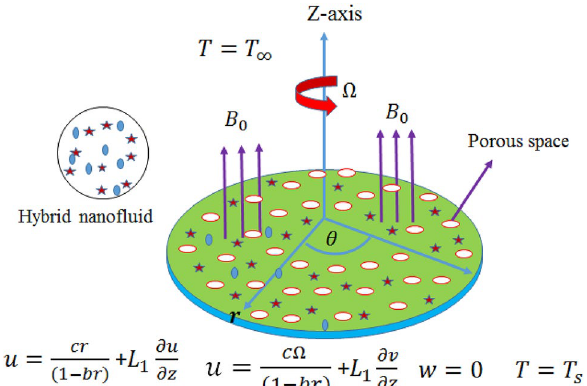
Figure 1. Flow physical